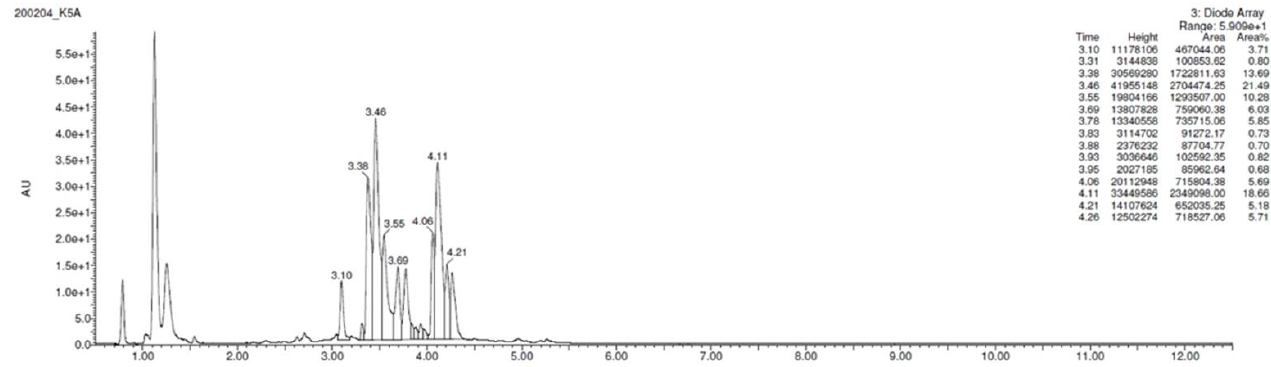
Figure 4. UPLC chromatogram of ketotifen (KETO) and its degradation products in buffer of pH 10.0 at 70 °C.